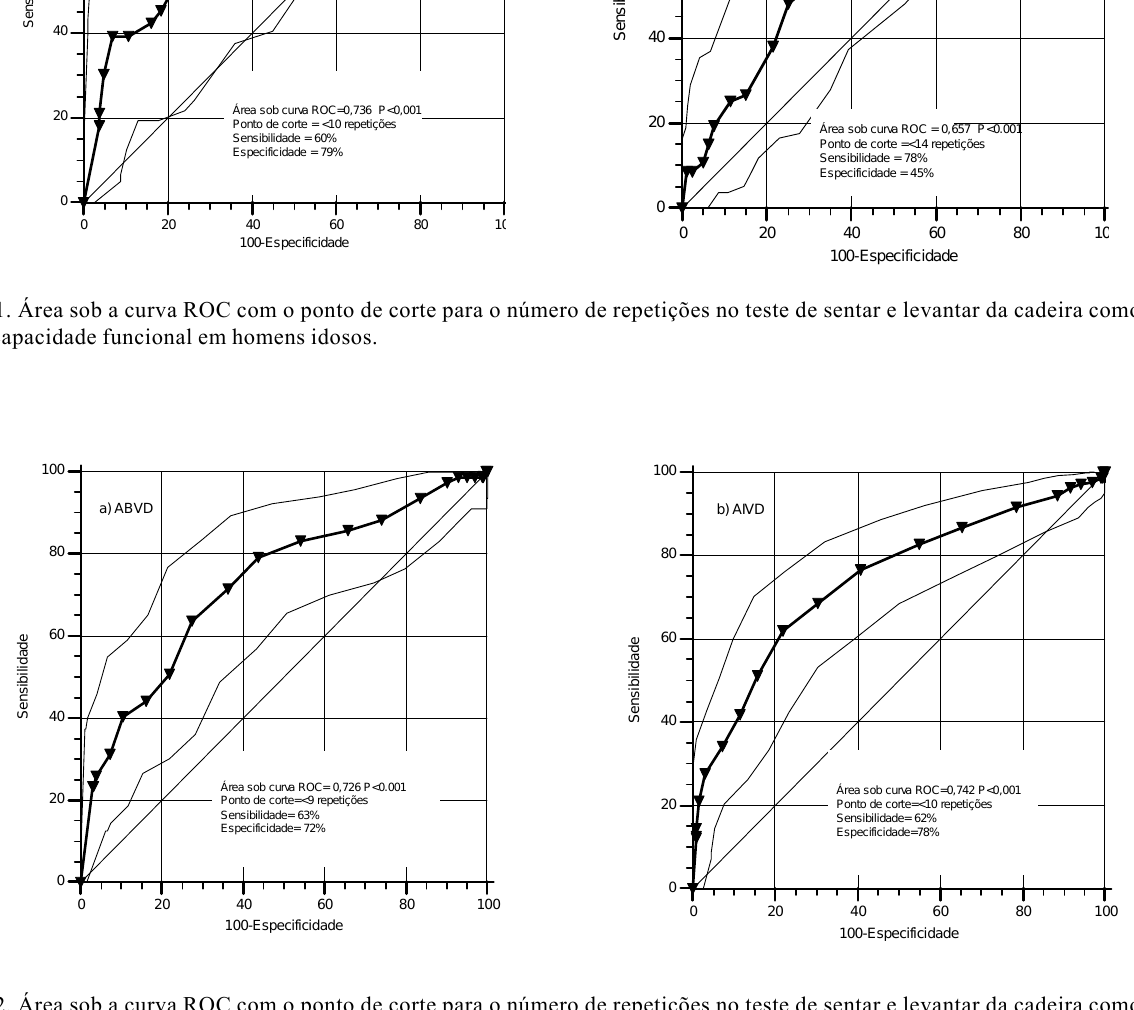
Figura 2. Área sob a curva ROC com o ponto de corte para o número de repetições no teste de sentar e levantar da cadeira como preditor para incapacidade funcional em mulheres